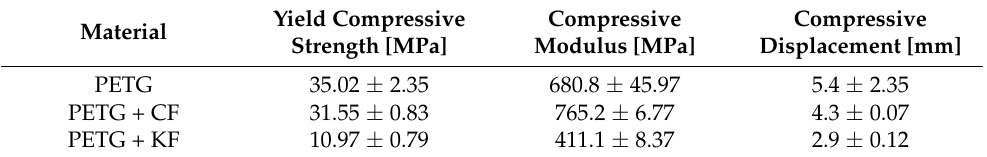
Figure 3. ( a ) Typical compressive curves of all materials studied; ( b ) Repeatability of the curves for PETG with carbon fibres. Table 2. Compressive properties.